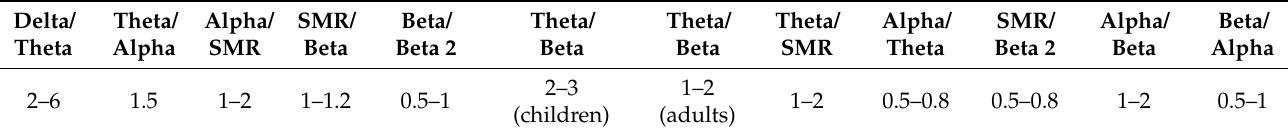
Table 1. Range of control values for the ratios of the compared